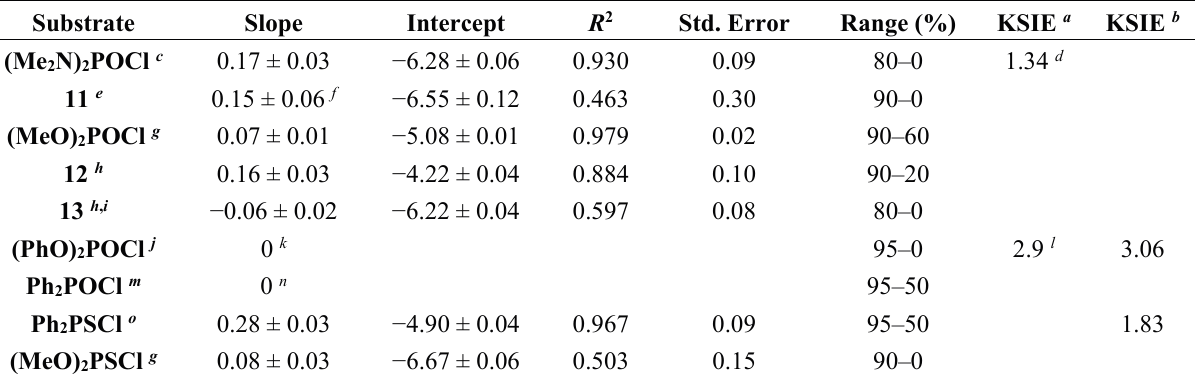
Table 3. Results (Equation (3)) for acetone-water (% v / v ) and kinetic solvent isotope effects (KSIE) in water and methanol for solvolyses of phosphorus chlorides at 25 °C (unless stated otherwise).